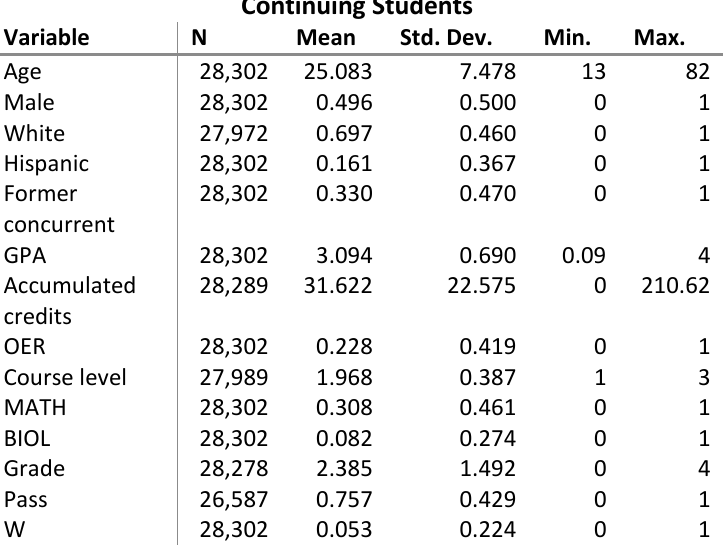
Figure 5. Table of descriptive statistics – Continuing students.